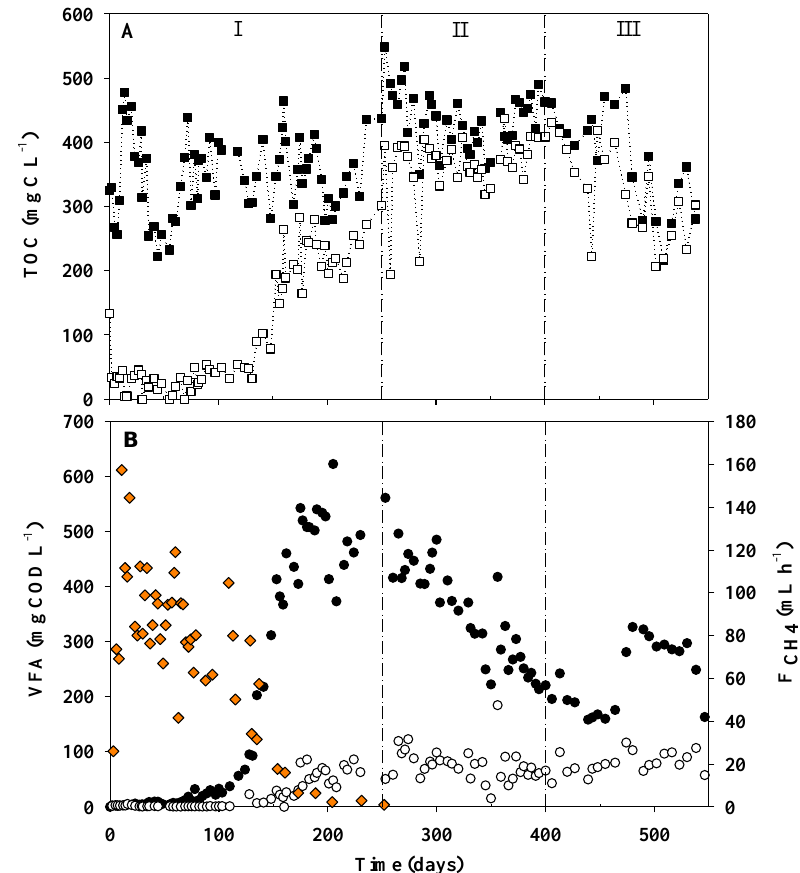
Figure 2. Performance of UASB. ( A ) TOC in the influent ( ) and in the effluent (□). ( B ) Volatile fatty acids (VFA) concentration: acetic acid ( ) and propionic acid ( ○ ) and flow of methane in the gas phase ( ). Vertical lines represent the different periods considered.